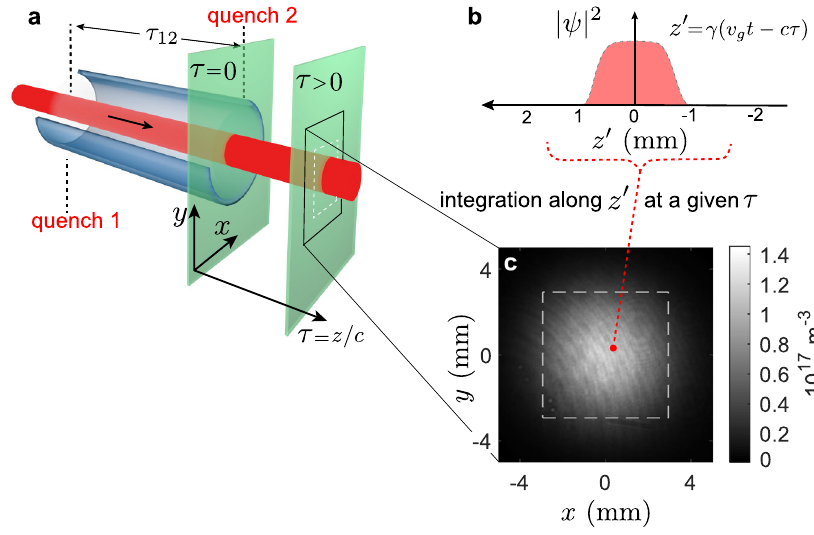
Fig. 1 The analogue universe. a The fl uid of light (red) is a laser pulse traversing a heated 85 Rb vapor cell. The axial position gives the effective time τ . The quenches occur at the entrance and exit of the vapor cell. τ = 0 corresponds to quench 2. The time between the two quenches is τ 12 . b The true time gives an effective third spatial dimension z ′ . c Typical image of the fl uid of light integrated along z ′ , given in units of photon density. An effective time τ = 103 ps after quench 2 is